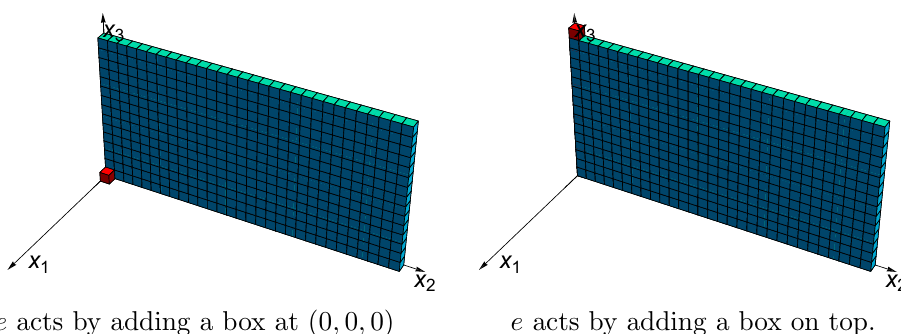
Figure 7 . The (cid:12)rst descendant states of the conjugate minimal